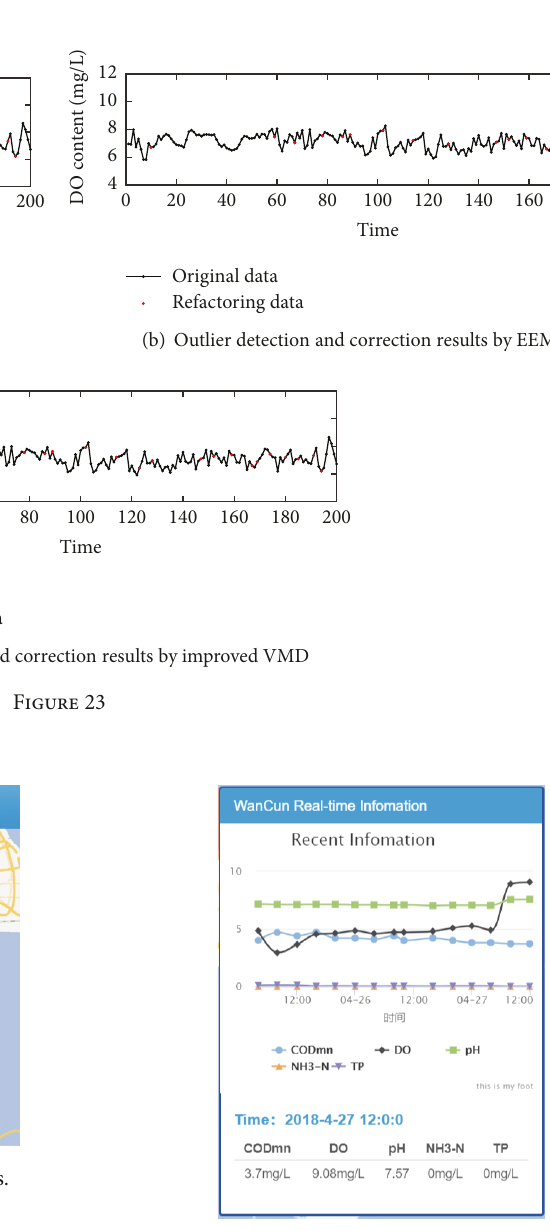
Figure 25: The engineering implementation effect of algorithm